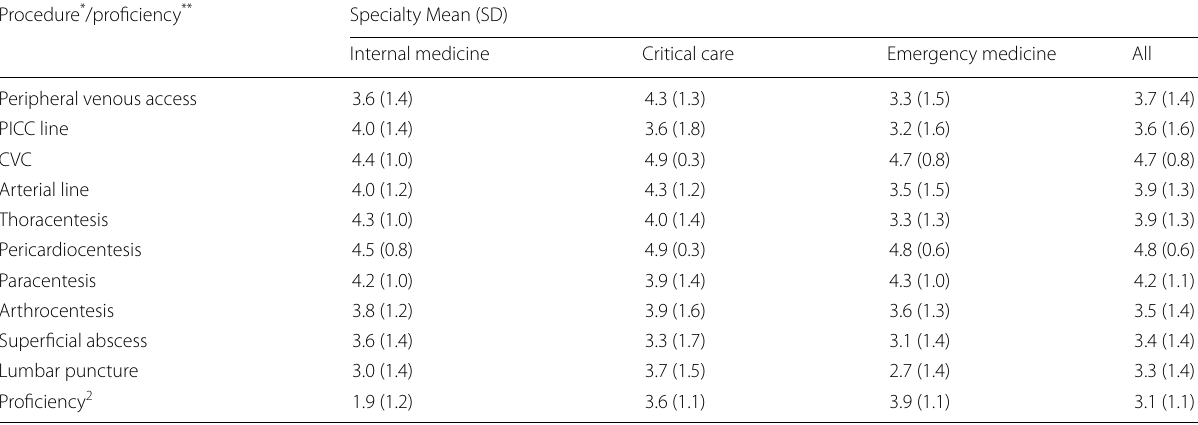
Data are stratified by specialty. * Perceived applicability of each procedure to the practice of each specialty was assessed using a Likert scale (1 very poor, 2 poor, 3 fair, 4 good, 5 very good). ** Proficiency in the sterile technique required to perform ultrasound-guided was self-reported on the same Likert scale. Data are presented as mean (standard deviation). Some of these data are also shown in Fig. 1. Data for internal medicine stratified by postgraduate year of training and gender are presented in Additional file 2: Appendix 2: Table 7. CVC, central venous catheter, PGY, postgraduate year of training; PICC, peripherally inserted central